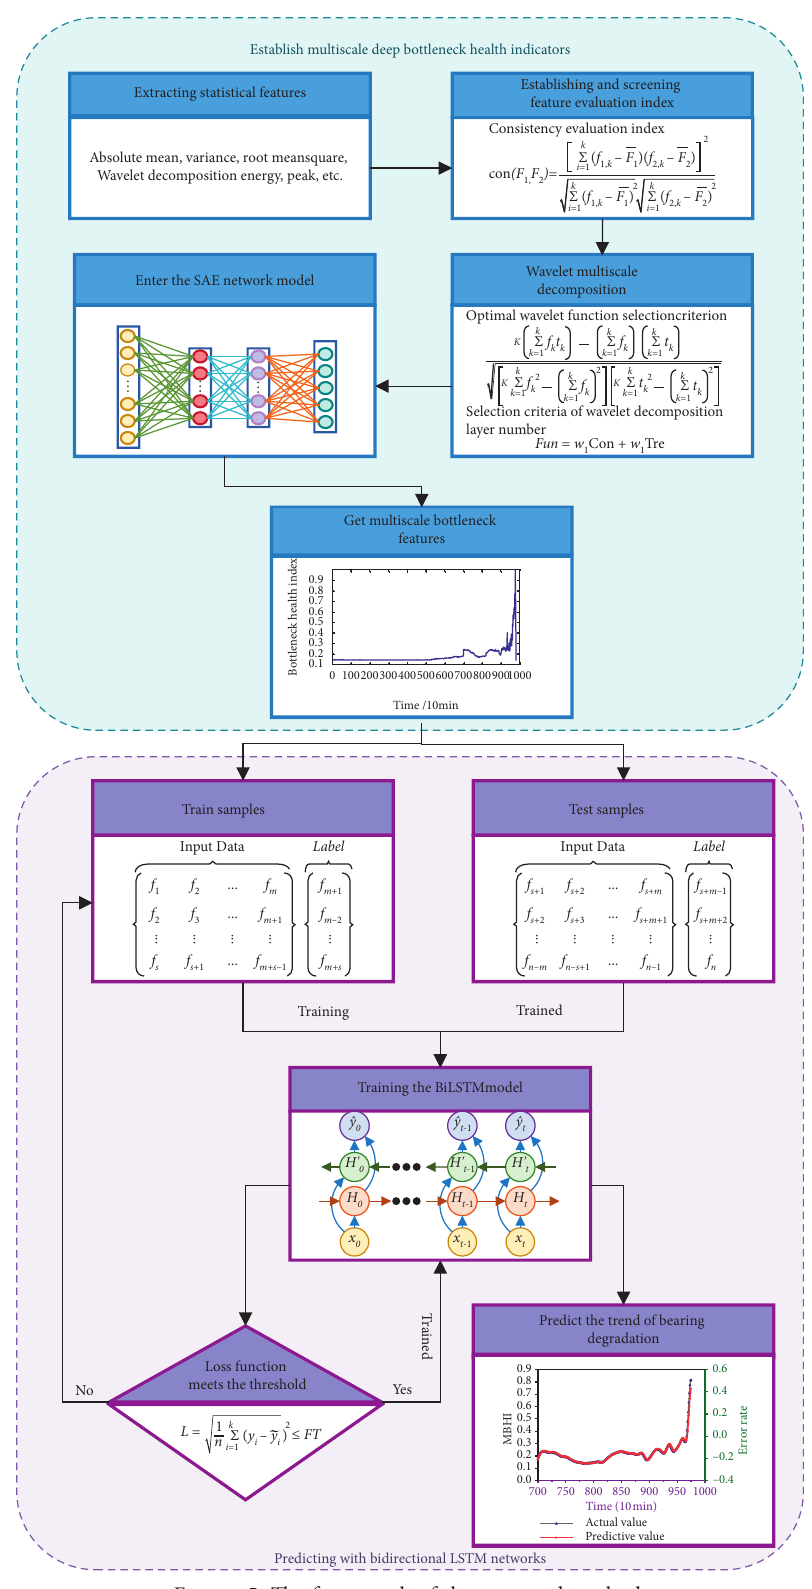
Figure 5: The framework of the proposed